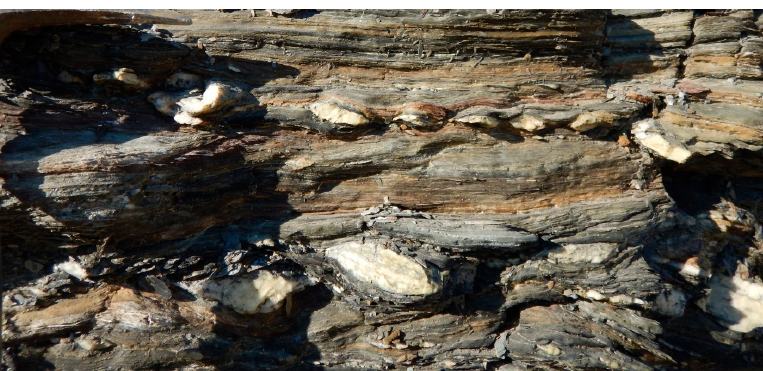
Figure 4. Boudinaged quartz veins subparallel to a composite planar fabric, defining a bedding-parallel foliation in zones with high strain.